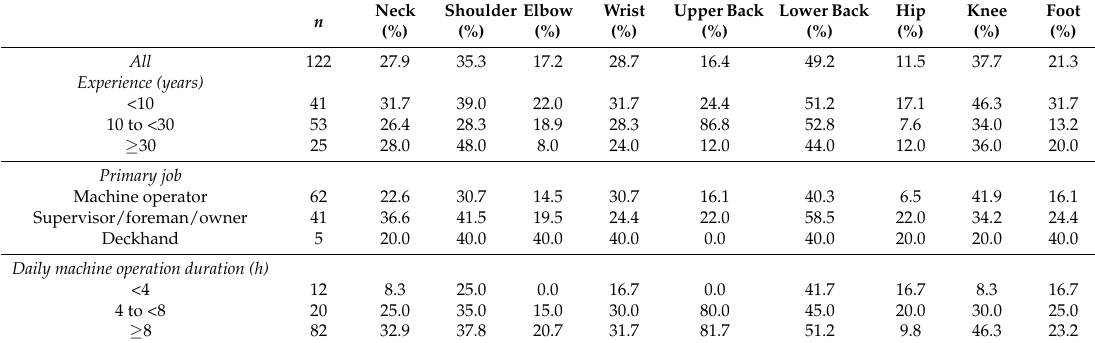
Table 2. Crude (i.e., unadjusted) 12-month prevalence of MSD symptoms by body